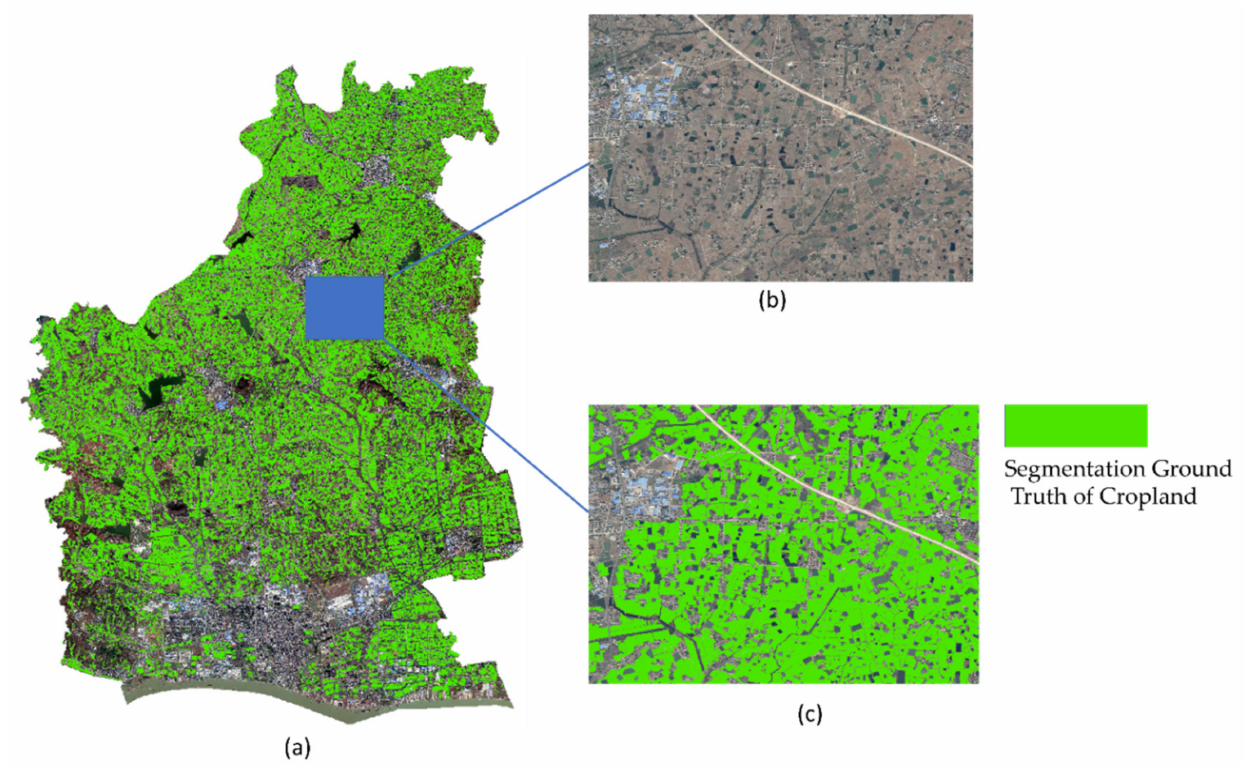
Figure 9. Large area of cropland extraction results in Yizheng City, Yangzhou City, Jiangsu Province. ( a ) Cropland results extracted from high-resolution remote sensing images, ( b ) true color image in the blue box in ( a ), ( c ) ground truth of semantically segmented cropland in ( b